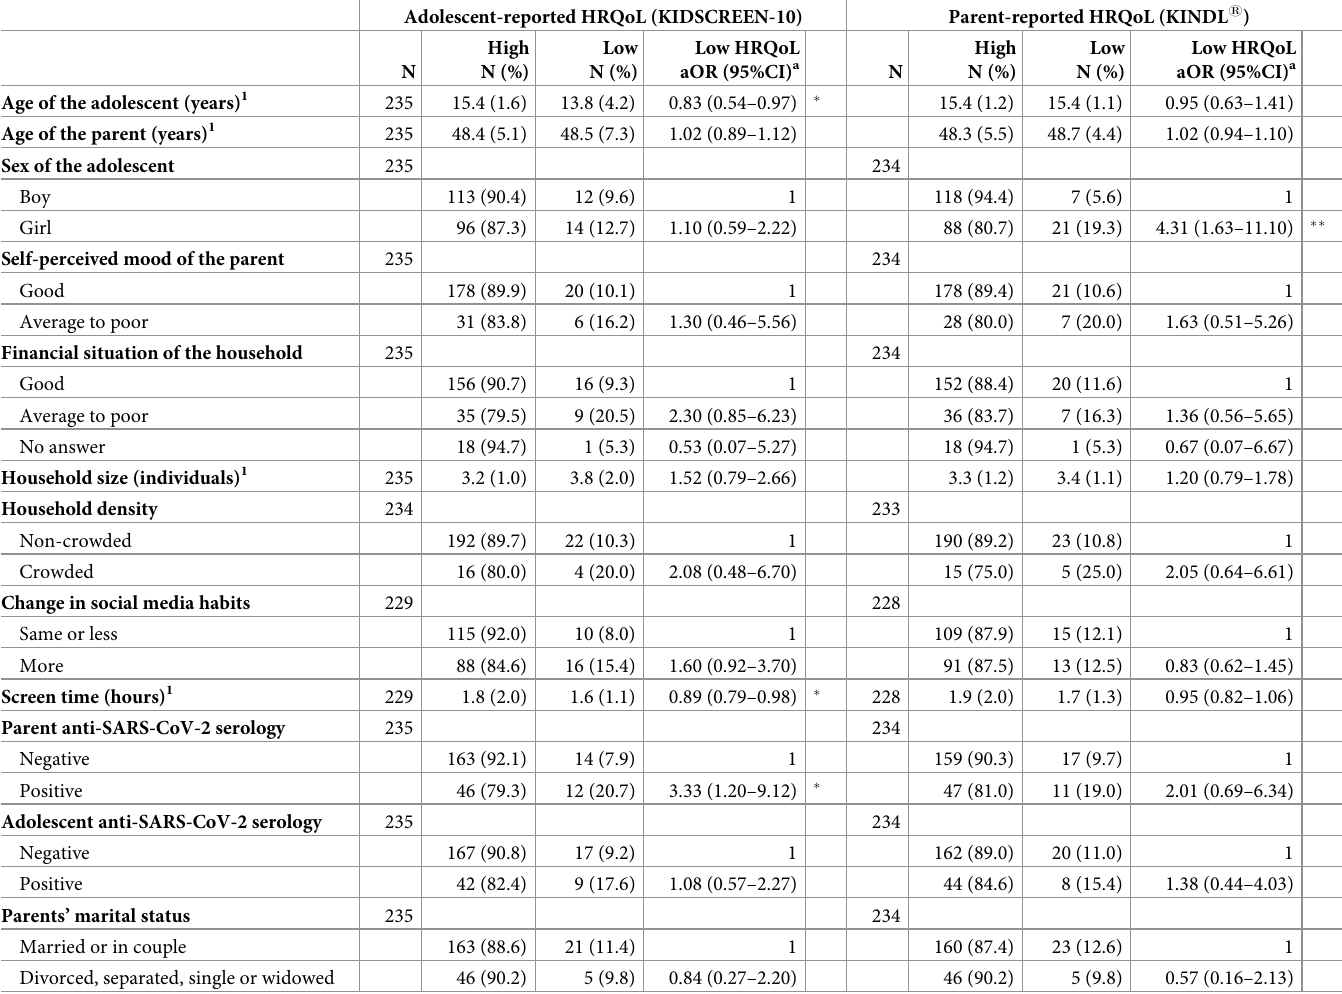
Table 2. Risk factors for adolescents’ self- and parent-reported low Health-Related Quality of Life (HRQoL). Adolescent-reported HRQoL